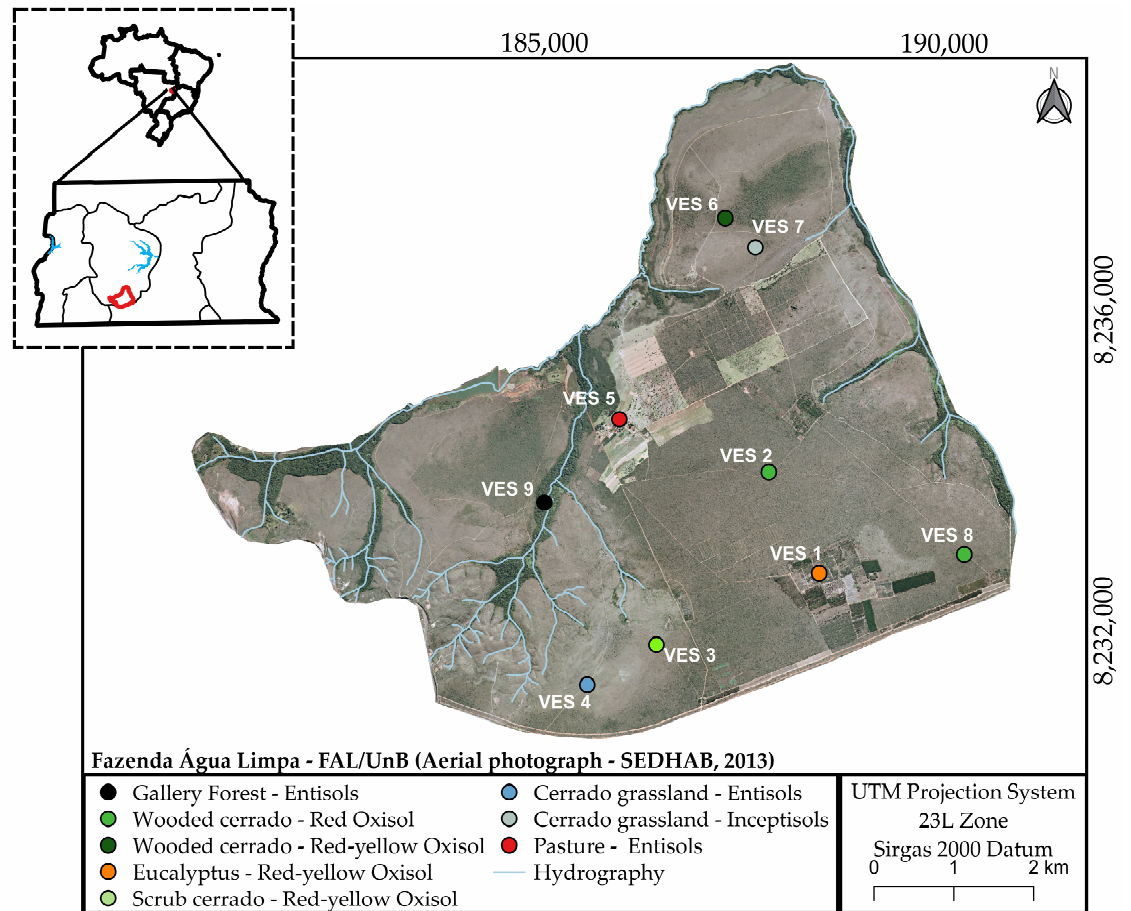
Figure 1. Fazenda Água Limpa (FAL/UnB), highlighted in red in the south-central portion of the Distrito Federal (DF), Brazil. Vertical electrical sounding (VES) locations in different pedological and land cover conditions, classified according to Natural Resources Conservation Service (NRCS); United States Department of Agriculture (USDA) [45] and Oliveira et al. [46], respectively. Aerial photograph provided by Secretaria de Habitação, Regularização e Desenvolvimento Urbano (SEDHAB) [47].